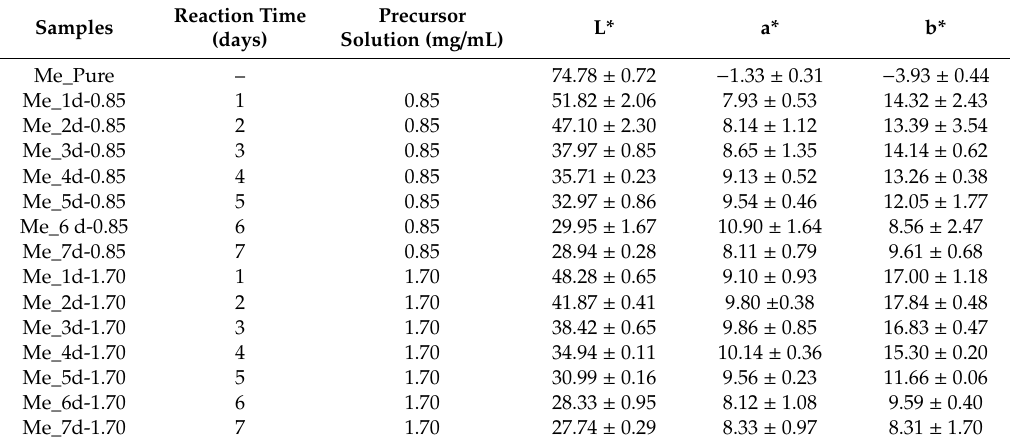
Table 1. Colorimetry CIE L*a*b* coordinates obtained for the pure ME foam and ME / Ag foams produced using 0.85 and 1.70 mg / mL precursor solutions as well as di ff erent reaction times from 1 to